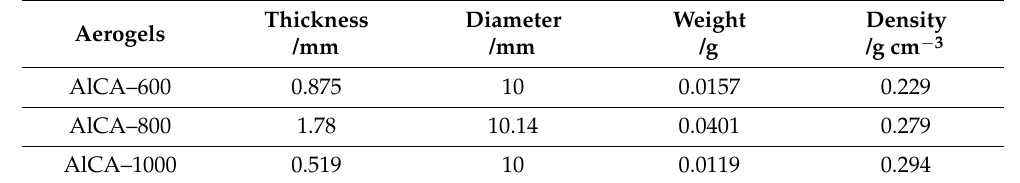
Table 2. Density of AlCAs.